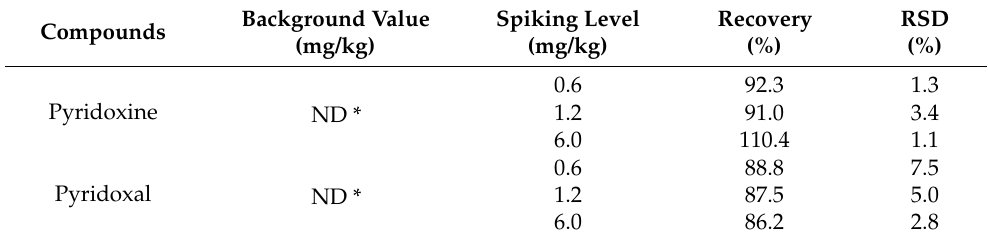
Table 2. Recovery and Precision of the method (n =